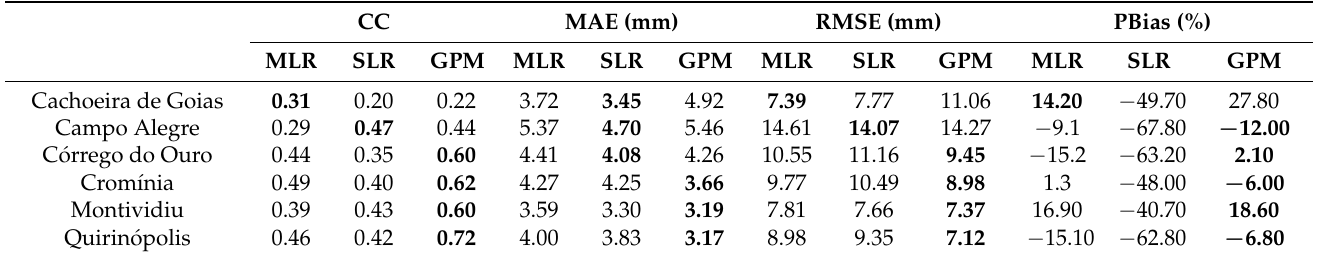
Table 2. Performance indexes of the three methods for filling daily missing data at the target